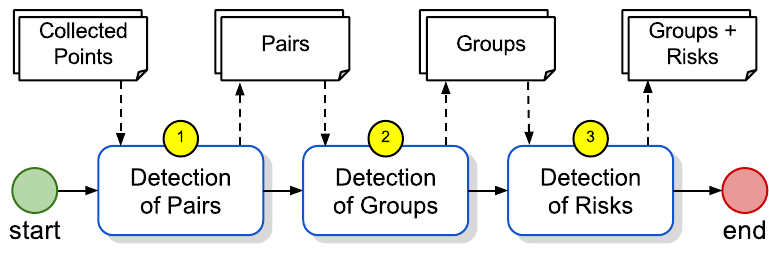
Figure 7. Processing steps. Source: the